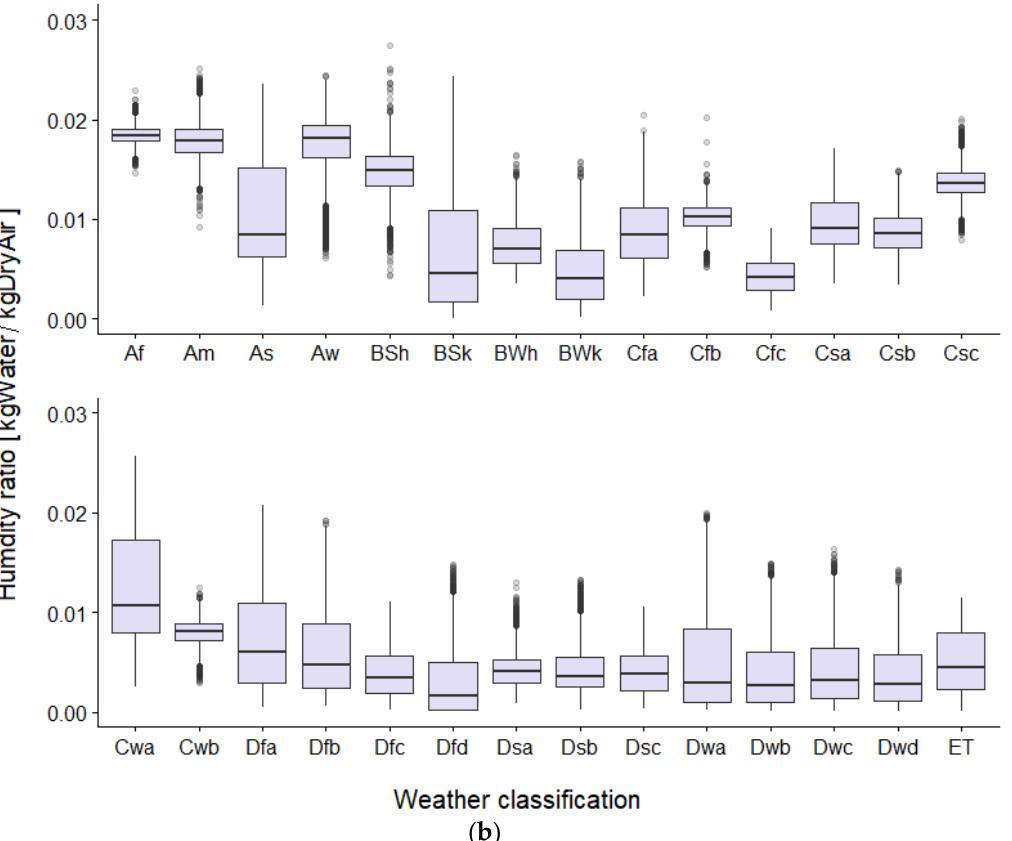
Figure 2. Weather conditions according to Koppen–Geiger climate classification: ( a ) outdoor air temperature; ( b ) humidity ratio.